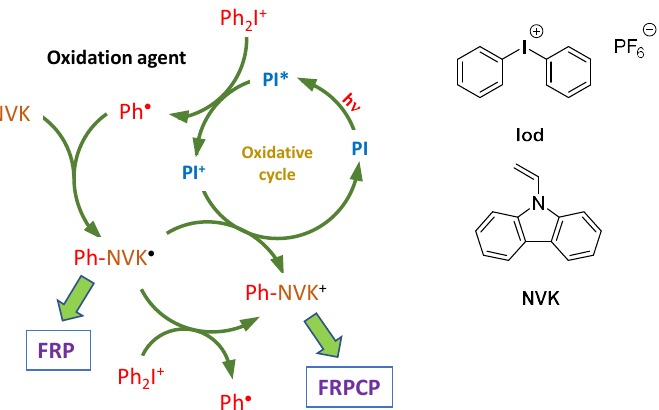
Figure 3. UV–visible absorption spectra of Cu-1 – Cu-3 in dichloromethane. Reproduced with permission from the authors of [62]. Copyright 2014 The American Chemical Society.